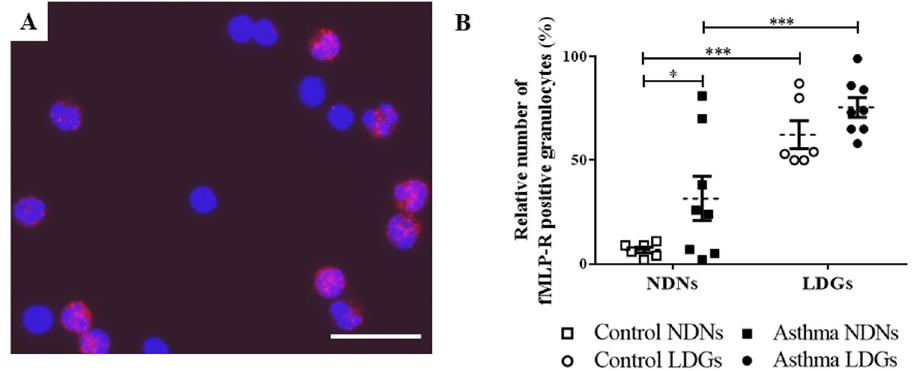
Figure 5. Immunofluorescence of fMLP-R in both layers of cells. ( A ) Representative photography at × 400 magnification (scale bar = 28 µ m) of using an Axio Imager M.1 microscope (Zeiss) of the low-density layer. fMLP-R appeared as red points by immunofluorescence, giving the cells containing this receptor a piknotic aspect. The DNA appears in blue. ( B ) Percentages of low-density neutrophils and normal-density neutrophils positive for fMLP-R. Each symbol denotes a single animal. Mean ± SEM for each studied population is shown. * p ≤ 0.05 and *** p ≤ 0.001.